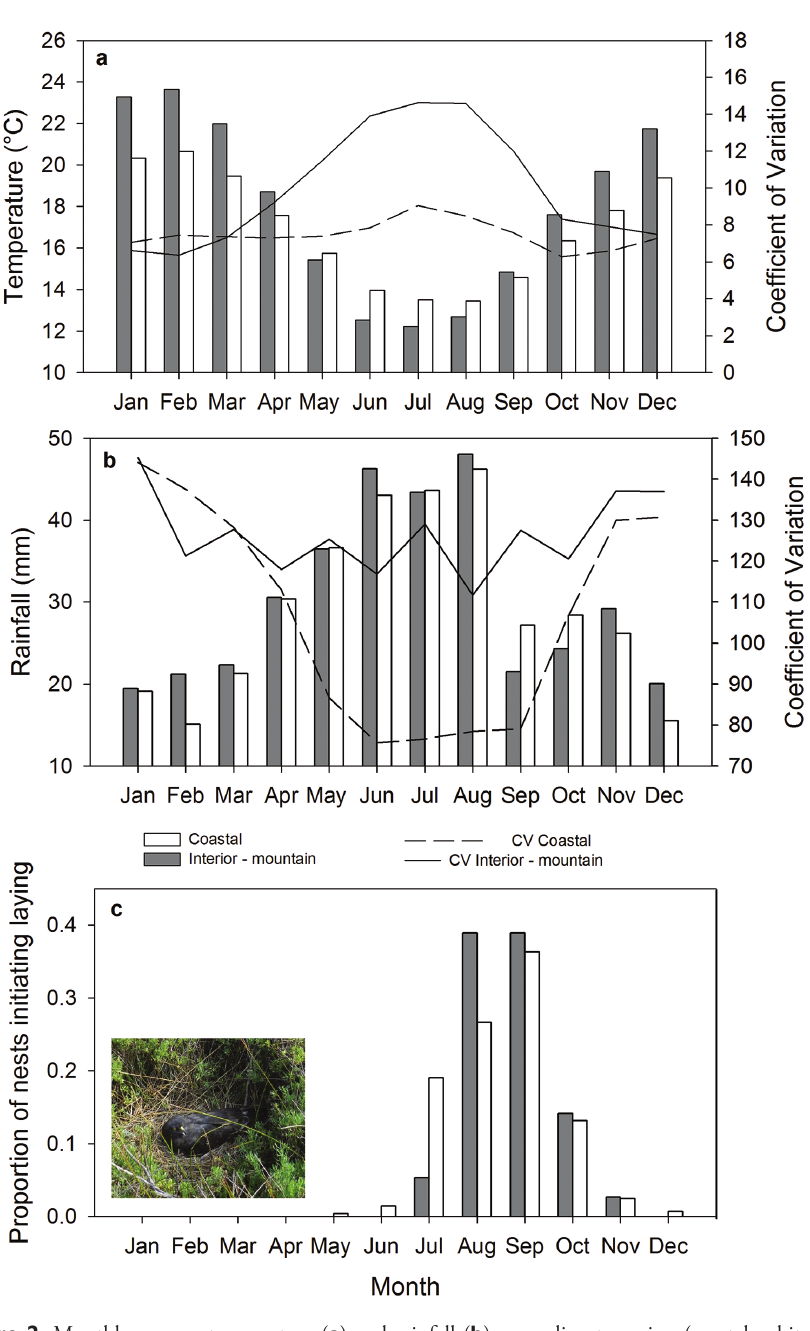
Figure 2. Monthly average temperature ( a ) and rainfall ( b ), according to region (coastal, white bars; interior-mountain, dark grey bars). Also presented are Coefficient of Variation (100x SD/Mean) for both climatic variables (dashed line for coastal, solid line for interior-mountain), as well as frequency distribu- tion of breeding initiation (n = 402) ( c ) during the study period